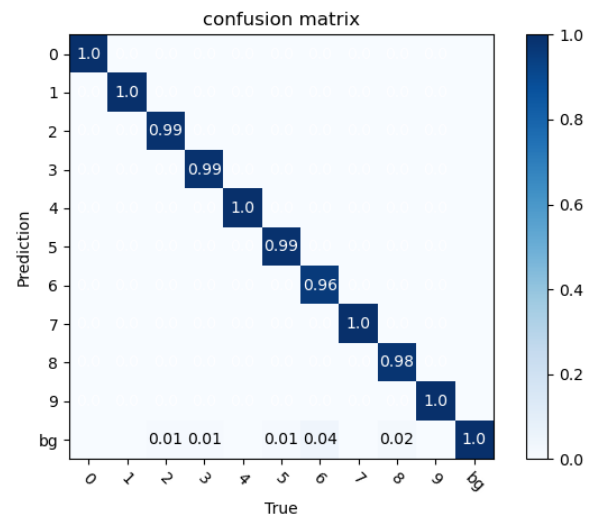
Figure 7. The confusion matrix of FLIMM.